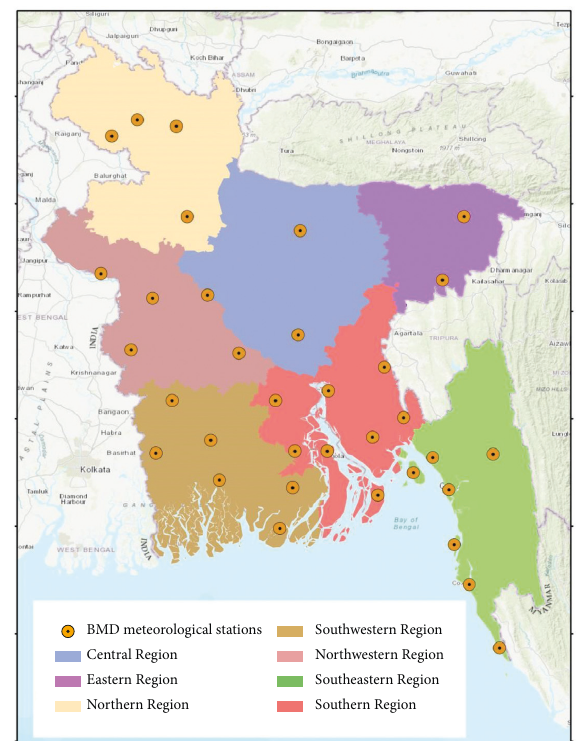
Figure 2: Seven regions of